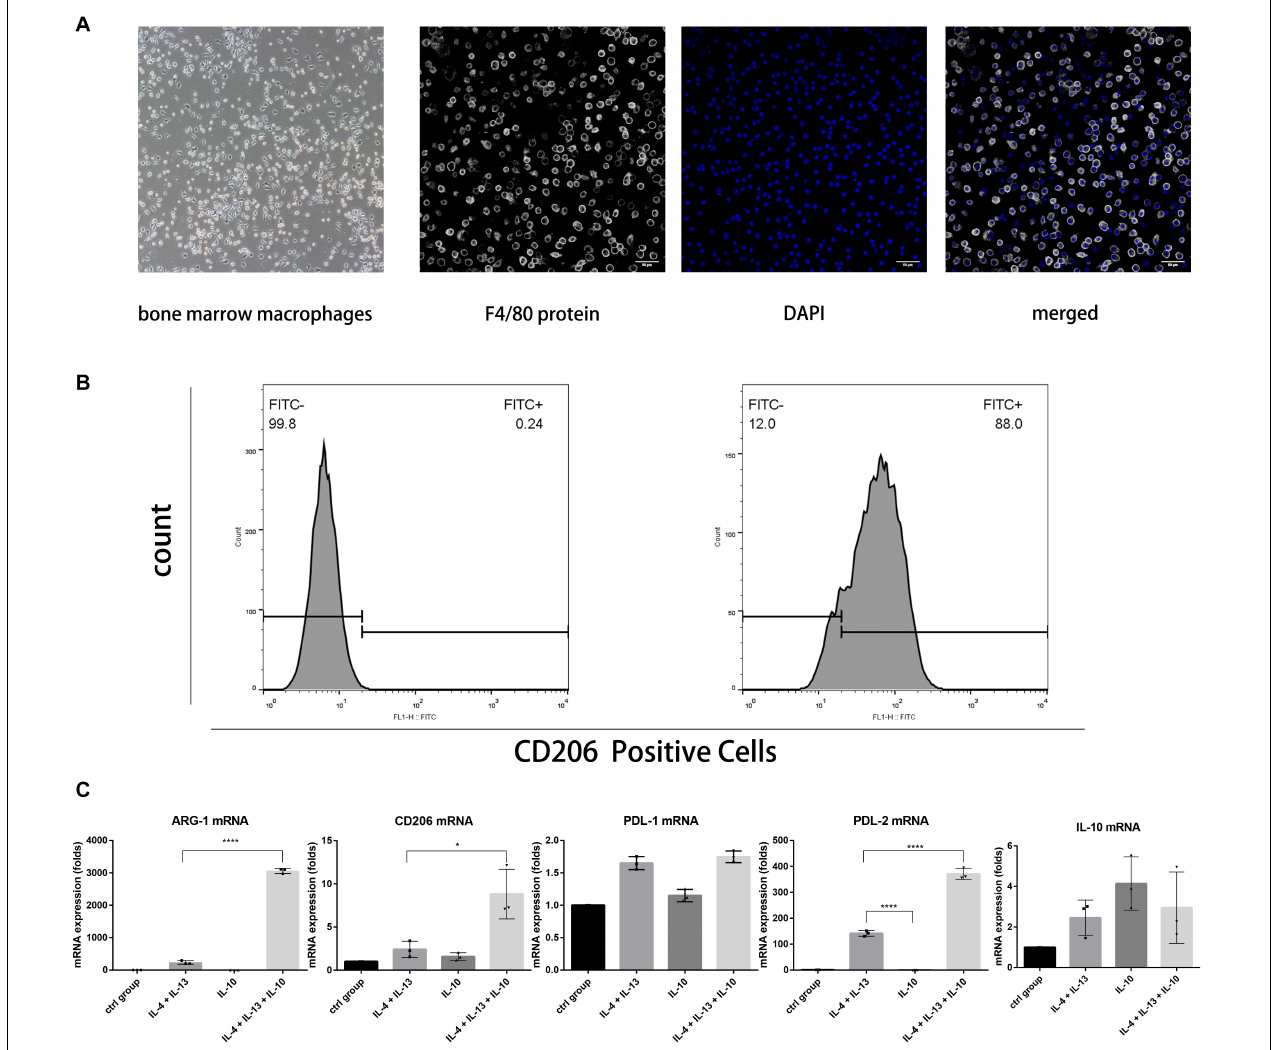
FIGURE 1 | The use of IL-4 and IL-13 with IL-10 in combination to stimulate macrophages resulted in much higher mRNA levels of ARG-1, CD206, and PDL-2 than without them. (A) The morphology of bone marrow macrophages and the F4/80 protein immunostaining. The bone marrow cells attached to the bottom and shown macrophage morphology after 5 days culture; the three fluorescent photos are showing F4/80 protein staining with fluorescent antibody, nucleus staining with DAPI and two staining merged together, respectively. (B) The flow cytometric analysis of CD206 intracellular staining of macrophages stimulated with IL-4 and IL-13. (C) The ARG-1, CD206, PDL-1, PDL-2, and IL-10 mRNA levels of macrophages in each group. The macrophages in the fourth group expressed higher levels of ARG-1, CD206, and PDL-2 mRNA. Data are shown as means ±